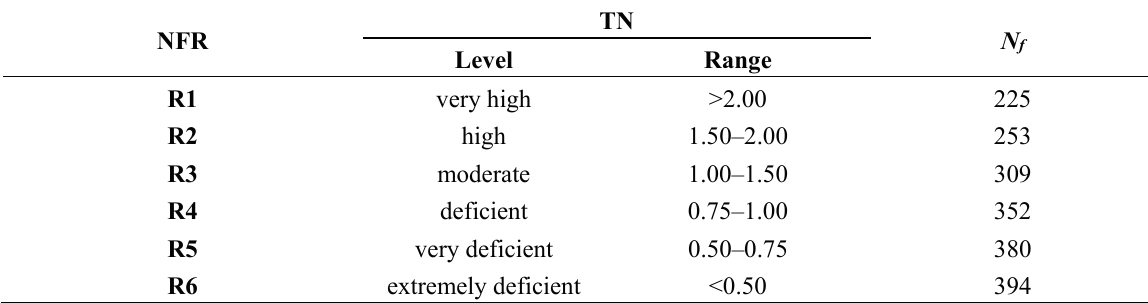
Table 1. Statistical descriptions of total nitrogen concentrations (g·kg − 1 ) at six levels and the required amounts (kg·ha − 1 ) of soil nitrogen fertilizer ( N f ) for different nitrogen fertilization rate (NFR)